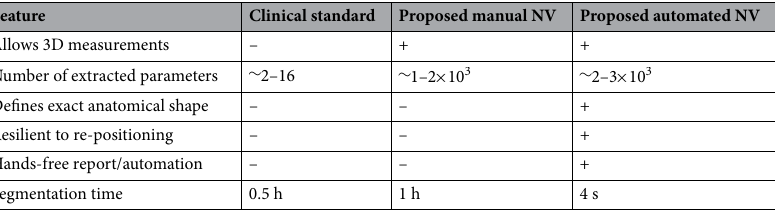
Table 1. Summary of key characteristics between clinical and proposed methods. NV stands for the negative